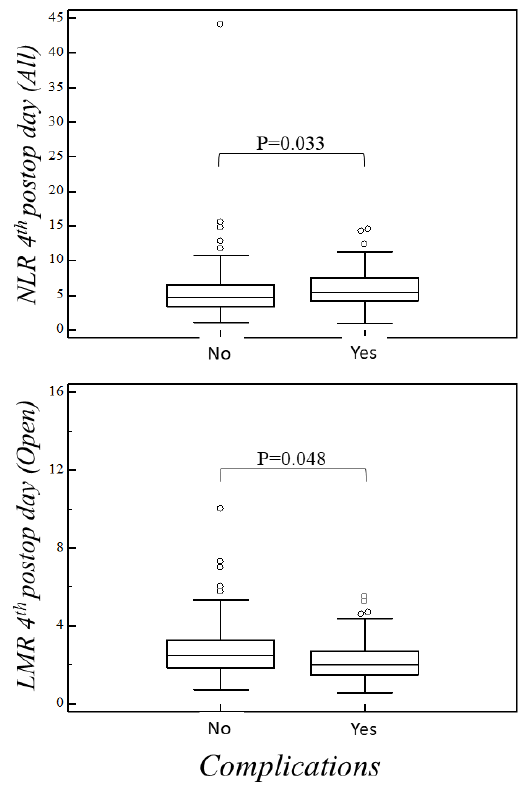
Figure 1. NLR fourth postop day (all patients). No complications vs. complications median 4.680 (IQR: 3.455–6.565) vs. 5.500 (IQR: 4.235–7.455), p = 0.033. LMR fourth postop day (open surgery). No complications vs. complications median 2.500 (IQR: 1.830–3.250) vs. 2.000 (IQR: 1.500–2.710), p = 0.048.